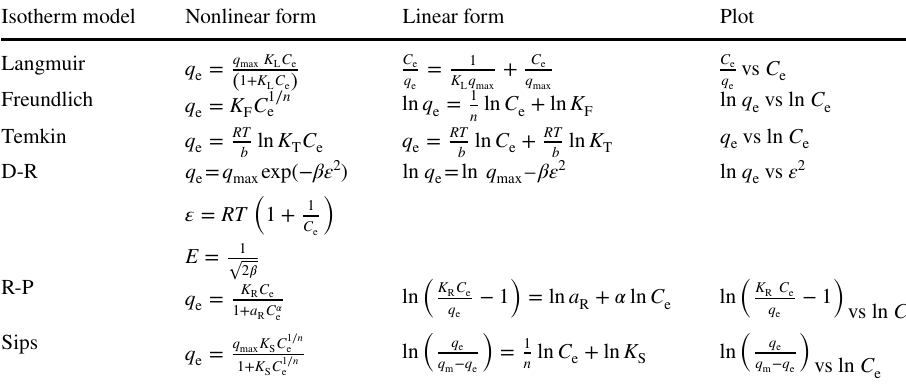
Table 1 The nonlinear and linear forms of the six isotherm